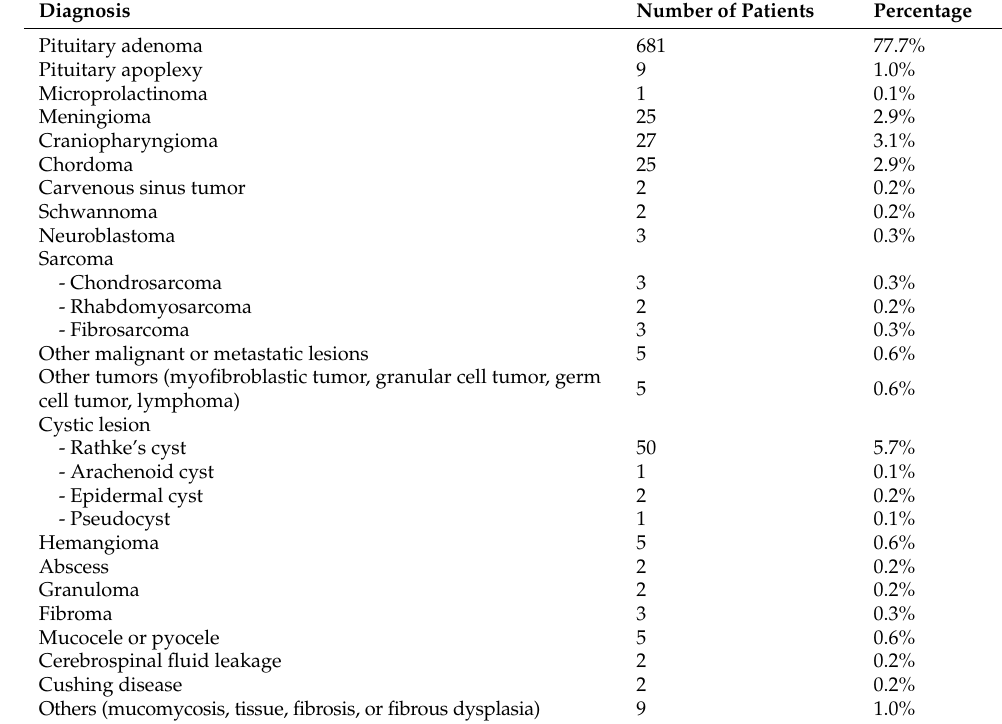
Table 1. Various lesions were resected using the endoscopic endonasal transsphenoidal approach.